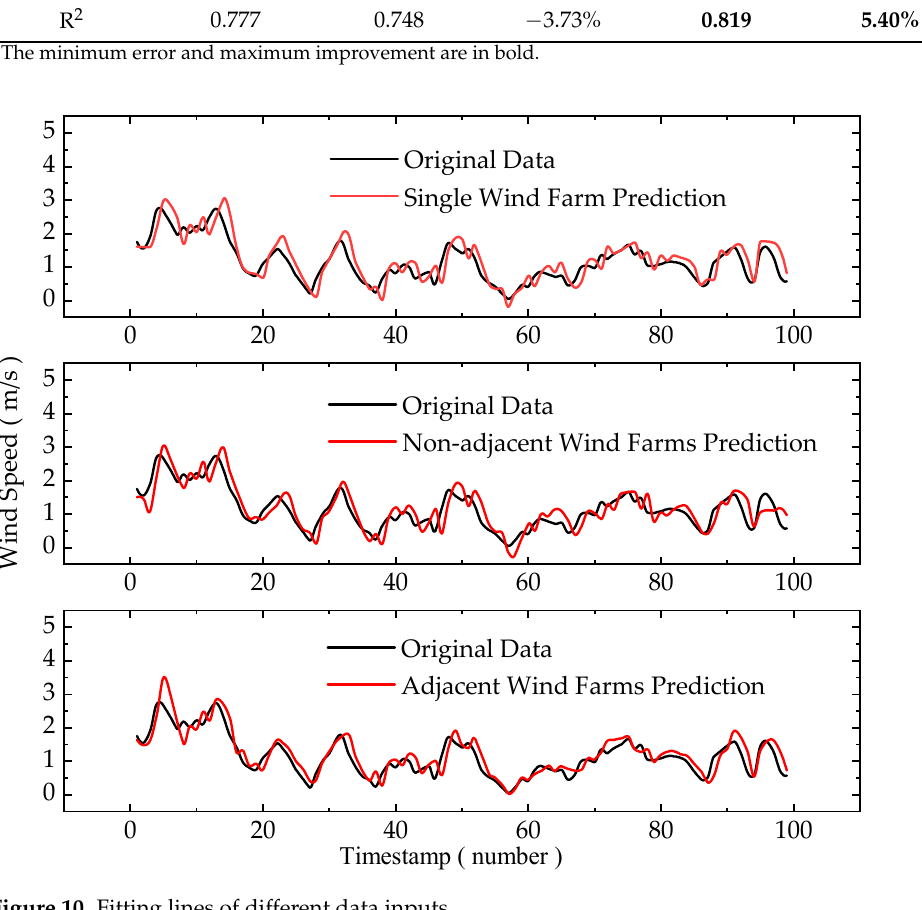
Figure 10. Fitting lines of different data inputs.